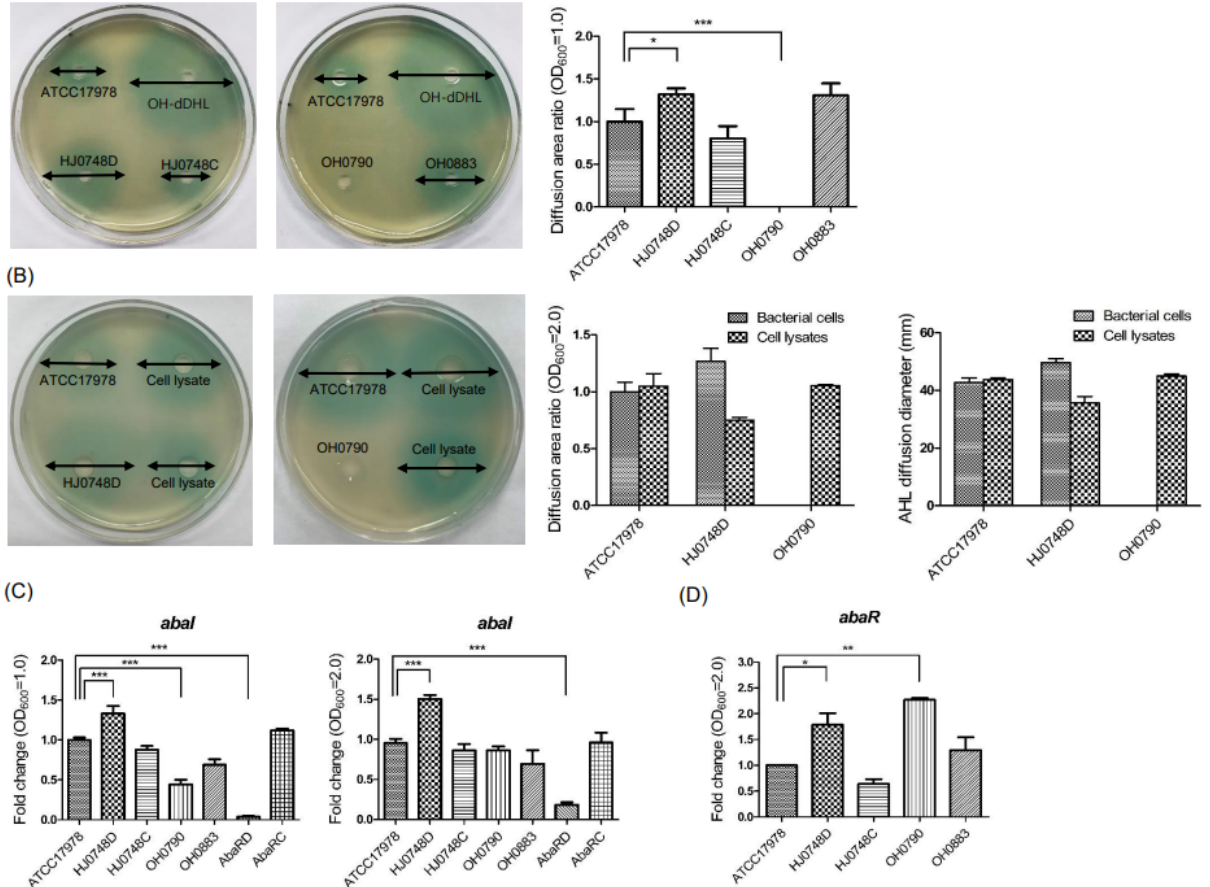
Figure 4. The production of autoinducers and expression of abaR and abaI in ∆ bfmR and ∆ bfmS mutant strains. ( A ) A. baumannii ATCC 17,978 (wild-type), HJ0748D ( ∆ bfmR mutant), HJ0748C ( bfmR -complemented strain), OH0790 ( ∆ bfmS mutant), and OH0883 ( bfmS -complemented strain) were cultured in LB without salt overnight. Ten microliters of the diluted sample, with fresh LB to an OD 600 of 1.0, were loaded onto the bioassay agar plates and were incubated for 22 h. Synthetic N-decanoyl-DL-homoserine lactone N-(3-hydroxydodecanoyl)-L-homoserine lactone (OH-dDHL) was used as a positive control. The experiments were performed three times independently. ( B ) A. baumannii strains were cultured in LB without salt overnight. Ten microliters of the diluted sample using fresh LB to an OD 600 of 2.0 and 80 µ L cell lysates were inoculated onto the plates overlaid with A. tumefaciens NT1 (pDCI41E33) for 22 h and the color zone developed was measured. ( C ) A. baumannii strains were grown in LB without salt to an OD 600 of 1.0 or 2.0 under static conditions. qPCR was performed to analyze the expression of abaI and abaR . The data are presented as the mean ± SEM of three independent experiments. * p < 0.05, ** p < 0.01, *** p < 0.001 compared to the WT